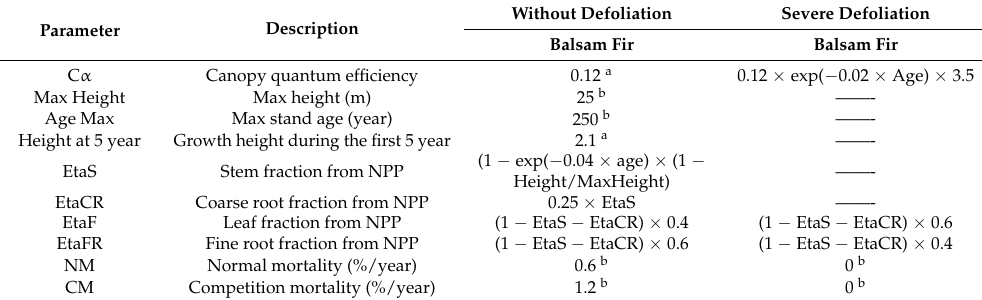
Table 3. Key parameter values used in simulations of the TRIPLEX-Insect model. Parameters including Etas, EtaCR, EtaF, and EtaFR during endemic periods are based on the default values in TRIPLEX 1.0. For alpha carbon (C α ), EtaF, and EtaFR, severe defoliation was defined when LAI in December was less than 20% of LAI in January during the same year. For NM and CM, severe defoliation means DM greater than